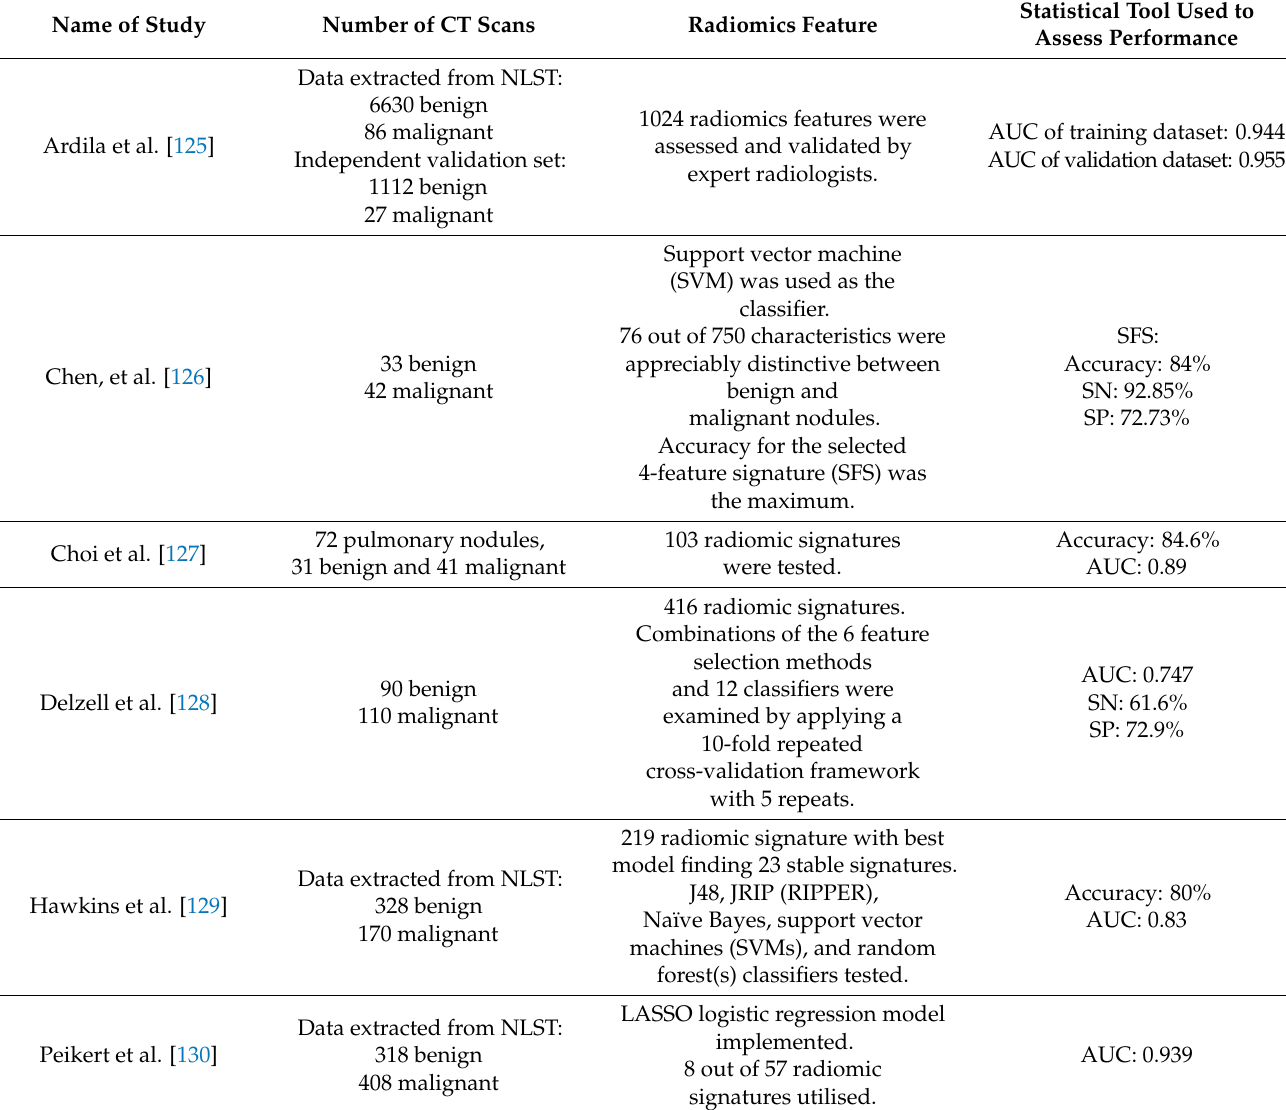
Table 3. Summary table showing studies of radiomics signatures to distinguish benign from cancerous lung